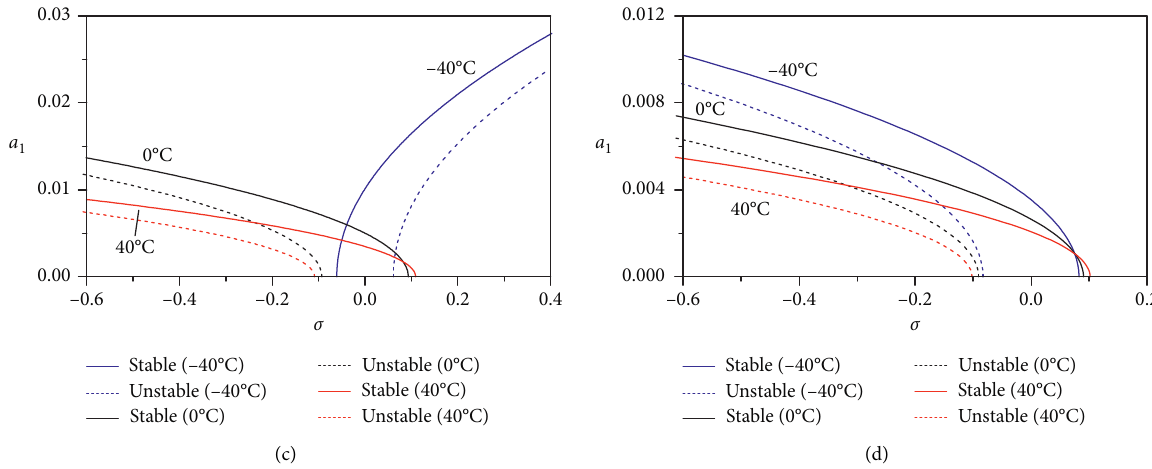
Figure 4: Temperature effects on relationships between detuning parameter σ and response amplitude a when K (B). (a) f � 0 . 0025, (b) f � 0 . 006, (c) f � 0 . 010, and (d) f � 0 . 015.